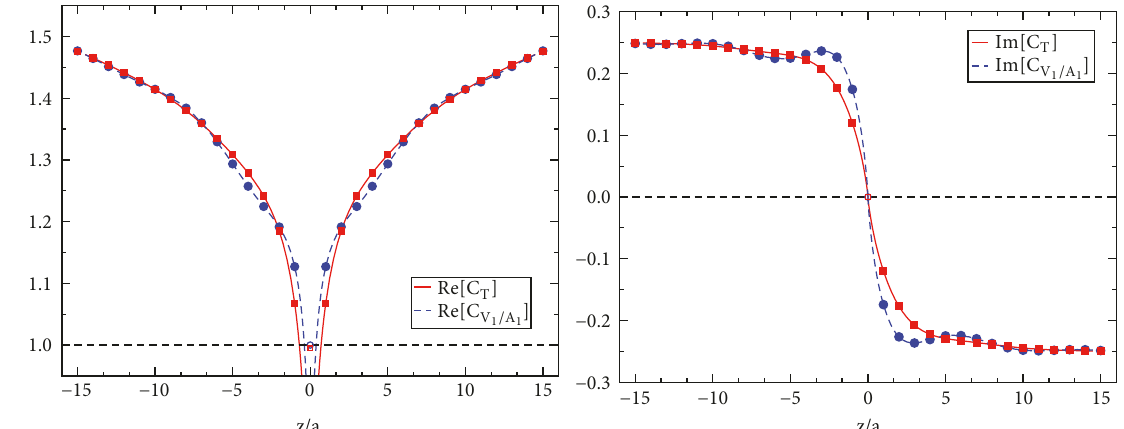
Figure 13: Real (left) and imaginary (right) parts of the conversion factors for the vector ( 𝑉 1 ), axial ( 𝐴 1 ), and tensor ( 𝑇 1 ) operators as a function of 𝑧/𝑎 in the Landau gauge. The RI 󸀠 renormalization scale is 𝑎𝑞 = (2𝜋/32)(4 + 1/4, 0, 0, 4) . Source: [106], reprinted with permission by the Authors and the American Physical Society.